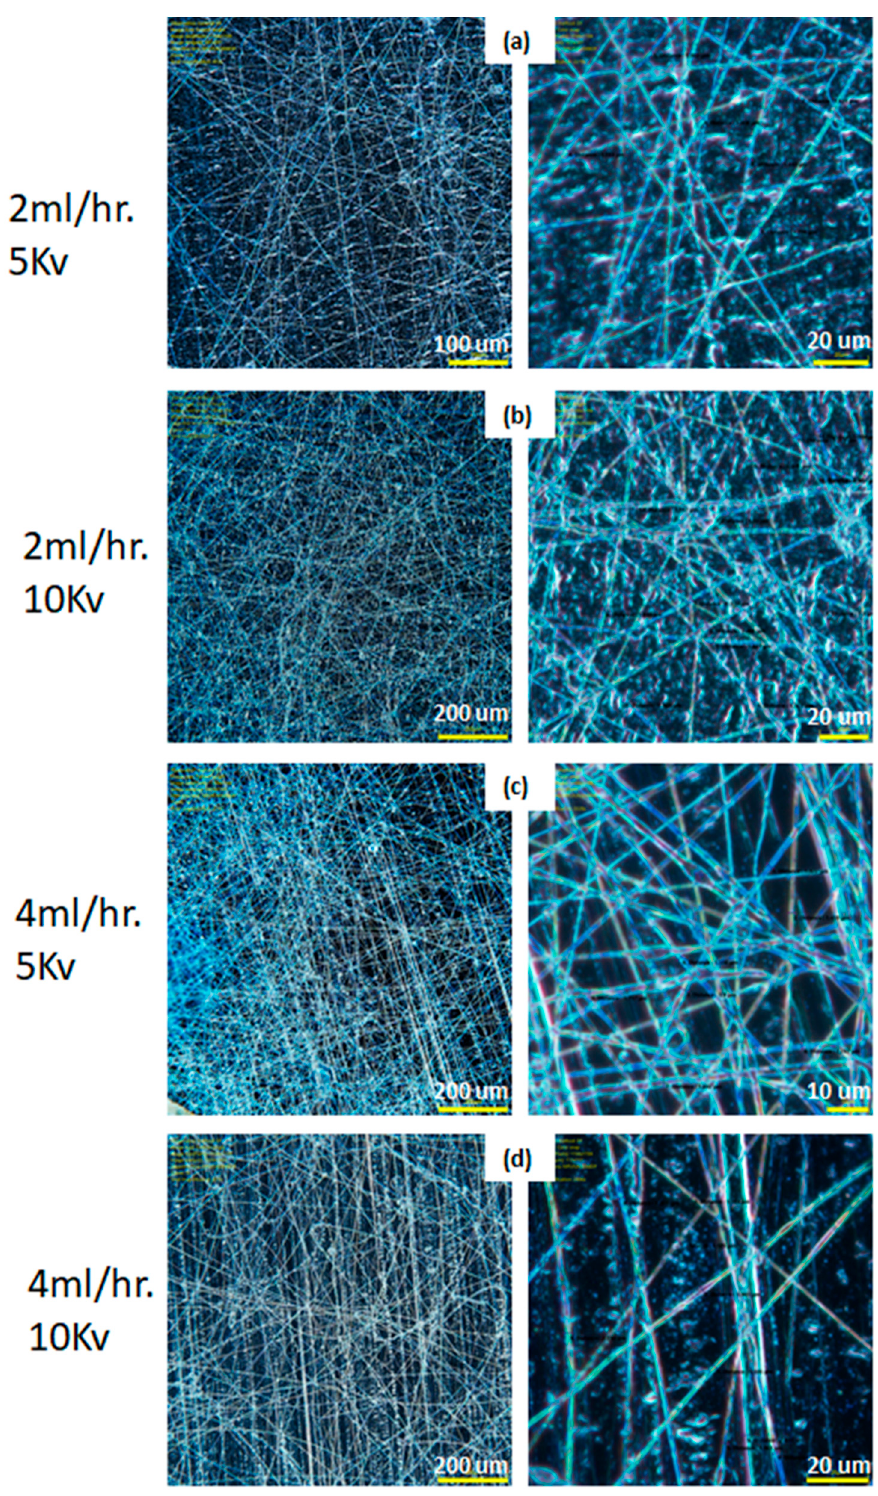
Figure 2. ( a ) Schematic of electrospinning setup with the drum operating at speeds of 55–80 rpm, ( b ) the nozzle, and ( c ) the assembled electrospinning setup.